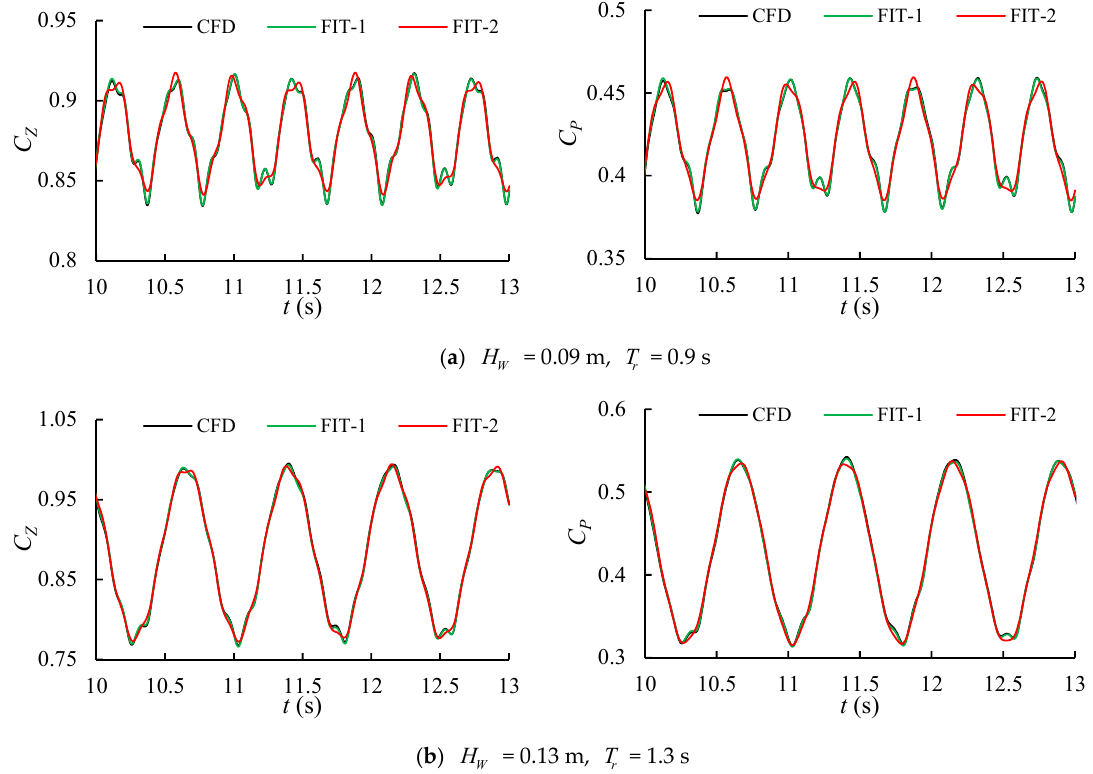
Figure 9. Comparison diagram of the computational fluid dynamics (CFD) calculated value and fitting value.